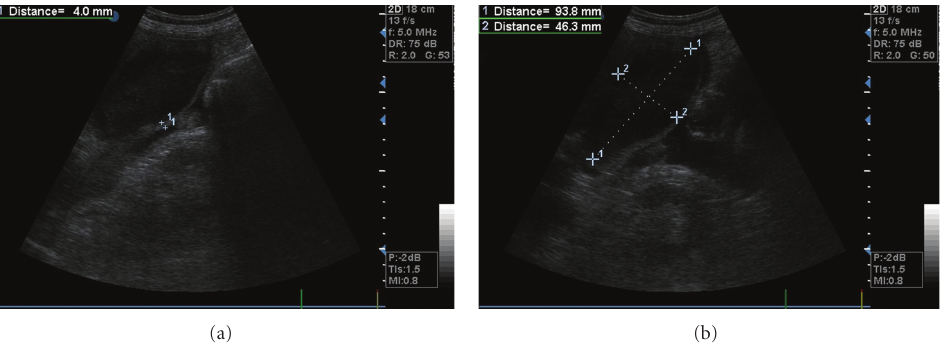
Figure 1: Gallbladder ultrasound depicting one patient with acute acalculous cholecystitis exhibiting wall thickening (4mm) in the presence of sludge (a) and marginally increased dimensions (93 × 46 . 3mm) with pericholecystic fluid